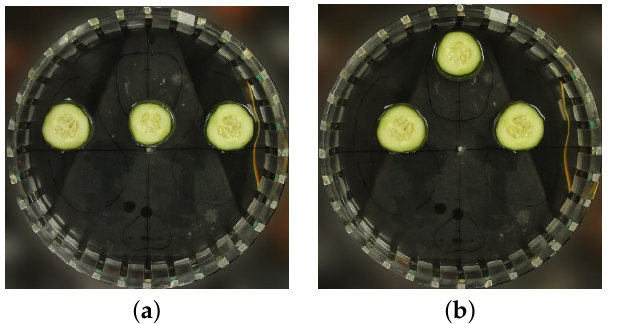
Figure 5. Electrical potential measurements were taken for two conductivity distributions. ( a ) Physi- cal linear arrangement. ( b ) Physical triangular arrangement.